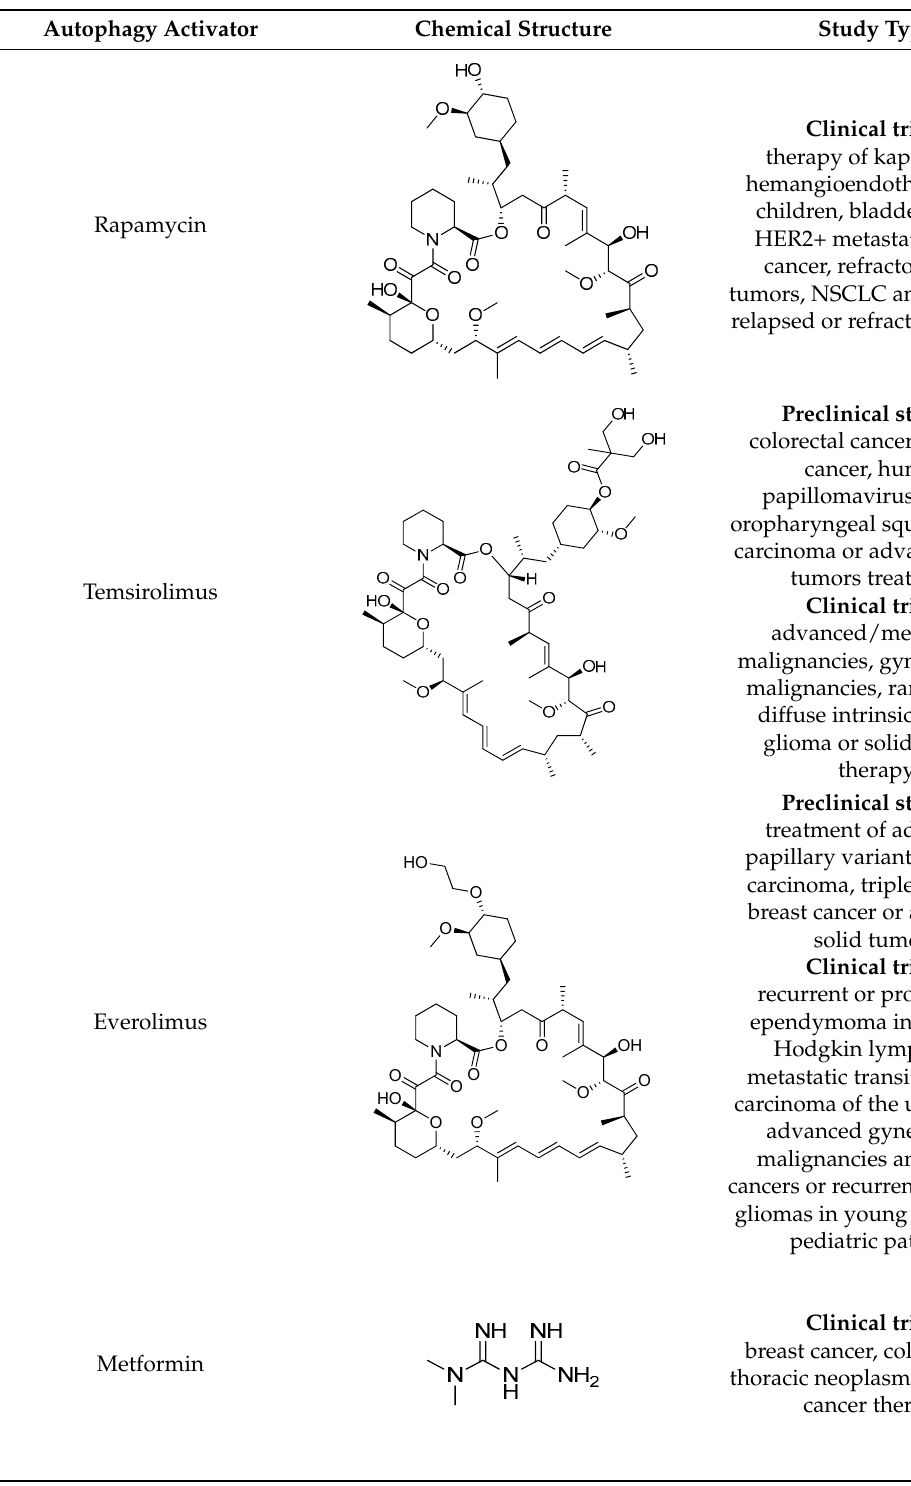
Table 4. Selected autophagy activators under clinical investigation.